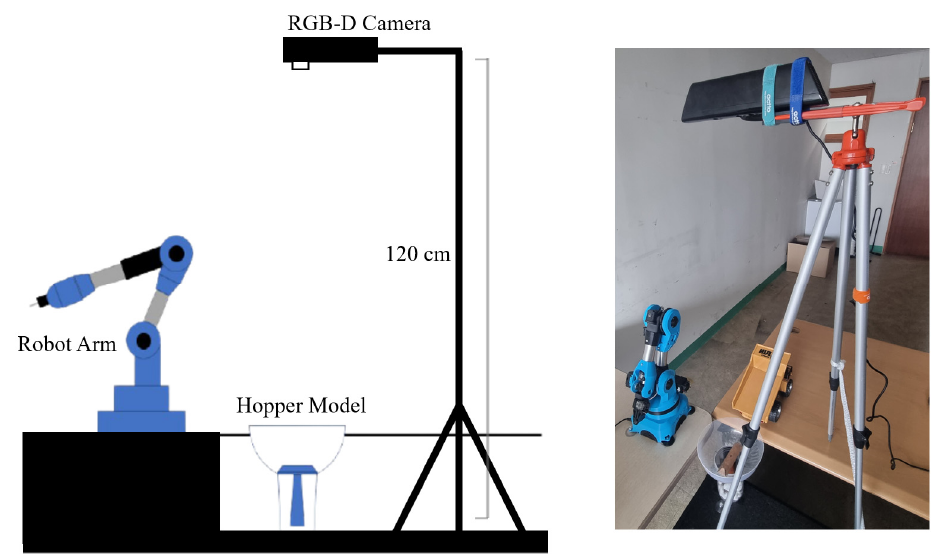
Figure 11. Conceptual diagram and photograph of the miniature smart hopper system inside the laboratory.